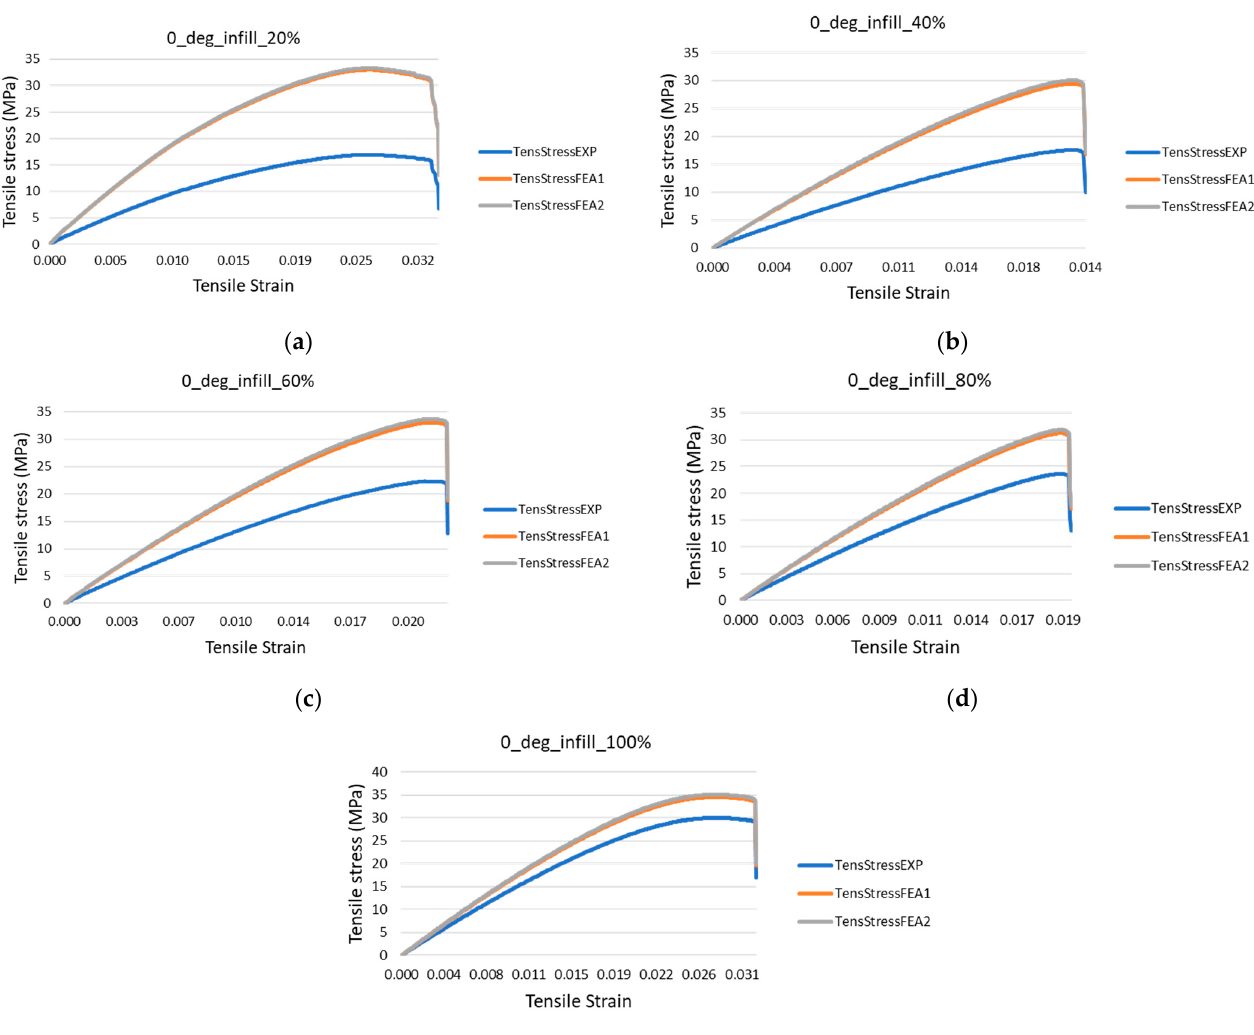
Figure 14. Stress-strain curves recalculated based on numerically estimated cross-sectional areas specimens with the infill rates: ( a ) 20%; ( b ) 40%; ( c ) 60%; ( d ) 80%; ( e ) 100%.